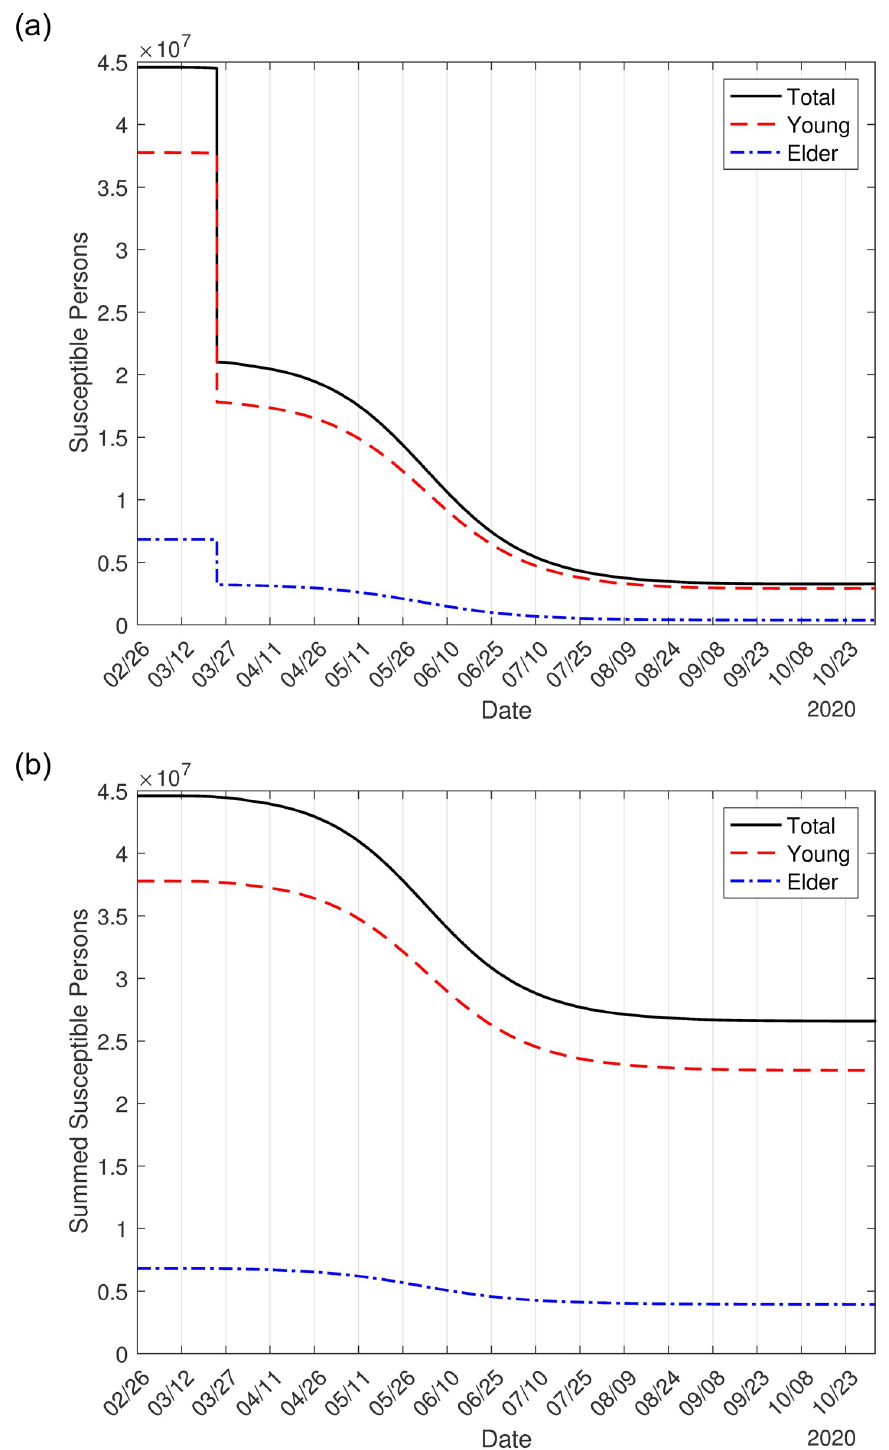
Fig 2. The circulating susceptible young S y , elder S o and total S = S y + S o persons (a), and the sum of the circulating and isolated susceptible populations S tot